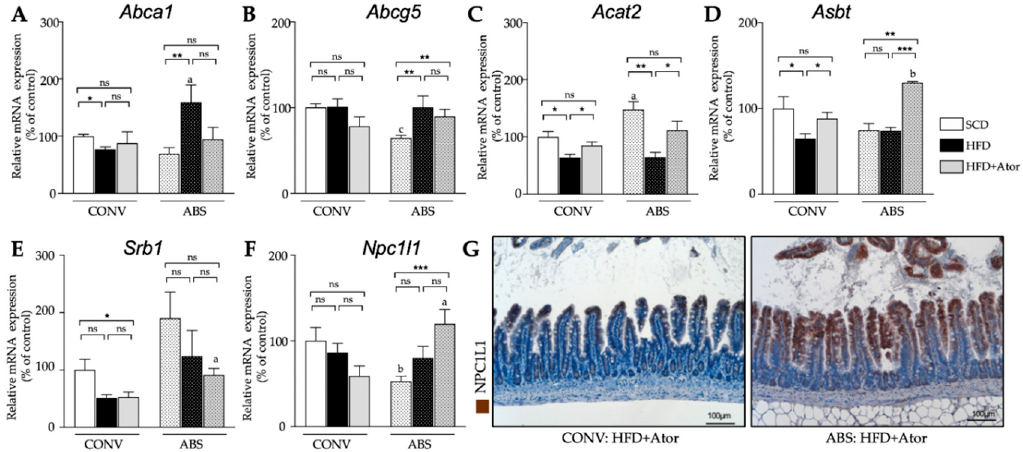
Figure 7. Intestinal gene and proteins. ( A – F ): Expression of cholesterol regulating genes in the small intestine and their alteration upon HFD and atorvastatin treatment in CONV ( n = 15) and ABS ( n = 20) mice. ( G ): Representative NPC1L1 stained histological sections of the ileum in CONV (left) and ABS (right) HFD fed mice under atorvastatin treatment. Error bars indicate SEM. * = p < 0.05, ** = p < 0.01; *** = p < 0.001.